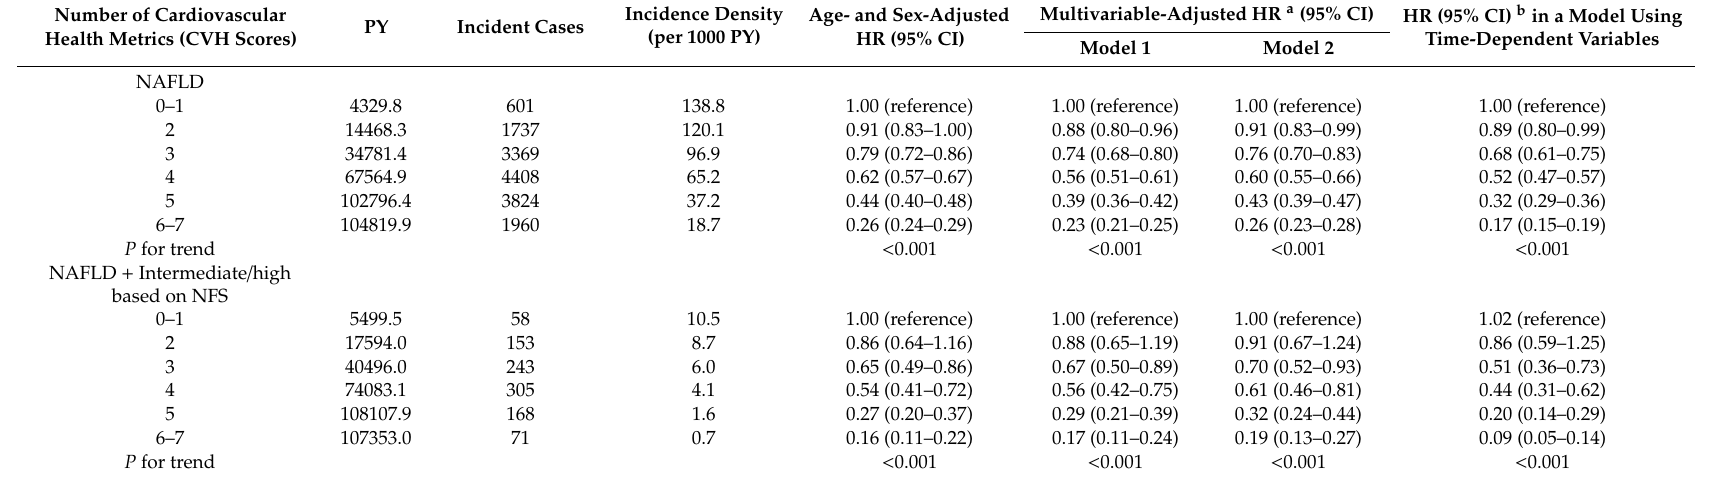
a Estimated from parametric proportional hazard models. Multivariable model 1 was adjusted for age, sex, center, year of screening exam, alcohol intake, education level, history of diabetes, history of hypertension, and history of cardiovascular disease; model 2: model 1 plus adjustment for HOMA-IR and hsCRP. b Estimated from parametric proportional hazard models with alcohol intake and number of cardiovascular health metrics as time-dependent categorical variables and baseline age, sex, center, year of screening exam, education level, history of diabetes, history of hypertension, and history of cardiovascular disease as time-fixed variables. BMI, body mass index; CI, confidence interval; CVH, cardiovascular health; HR, hazards ratio; NAFLD, nonalcoholic fatty liver disease; NFS, NAFLD fibrosis score; PY,